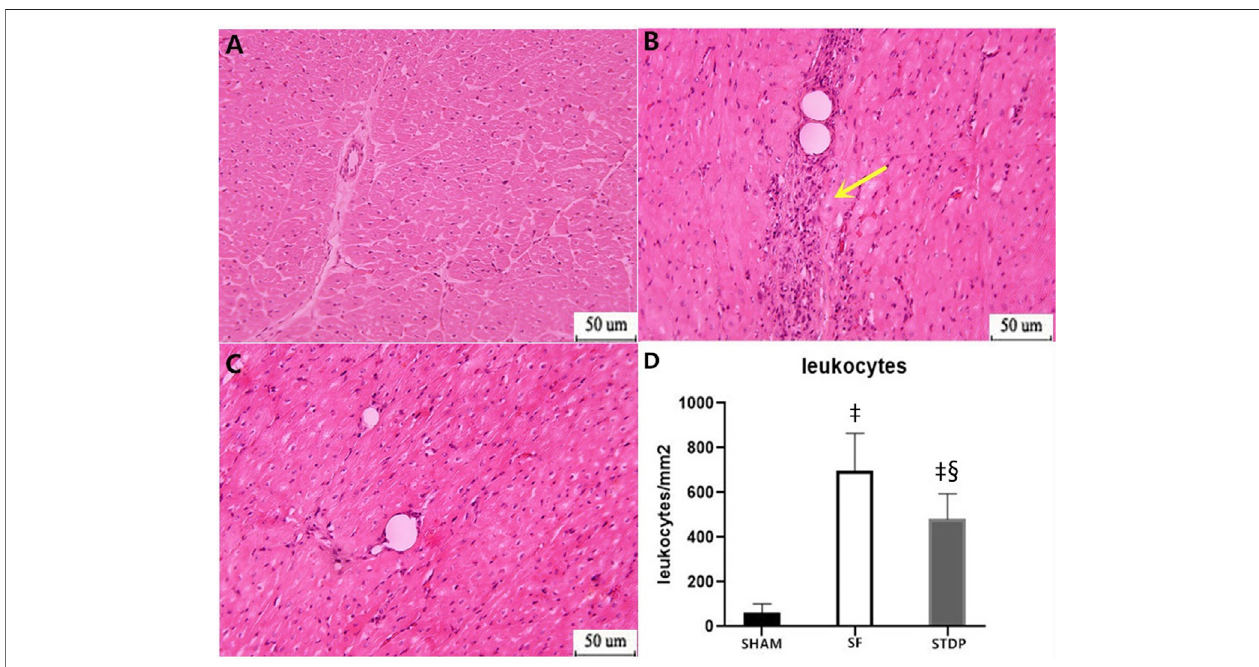
FIGURE 5 | HE staining analysis of the myocardial specimen (myocardial infarction area) 7 days after operation. (A) SHAM group × 200: (B) SF group × 200; (C) STDP group × 200: (D) Quanti fi ed and showed results in the bar graph below the fi gure. In the SF group, in fl ammatory cell in fi ltration was obvious at the ischemia area. In fl ammatory cell in fi ltration was also observed in the STDP group. Compared with the SF group, in fl ammatory cell in fi ltration decreased in the STDP group. Yellow arrows indicatealarge in fi ltration ofin fl ammatorycells.Dataarepresentedasthemean±SD. p < 0.05 ‡ vs. Sham group, and§vs. SFgroup ( n =6for each group).